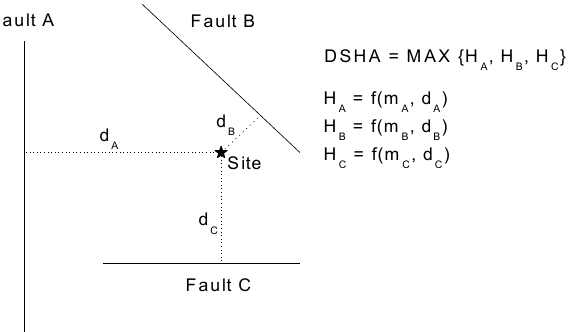
Figure 1. Schematic diagram illustrating the analytical framework of DSHA, where the solid star represents a study site, H denotes the seismic hazard induced by each source, m and d are the maximum earthquake magnitude and shortest source-to-site distance, and f is the function of a ground-motion